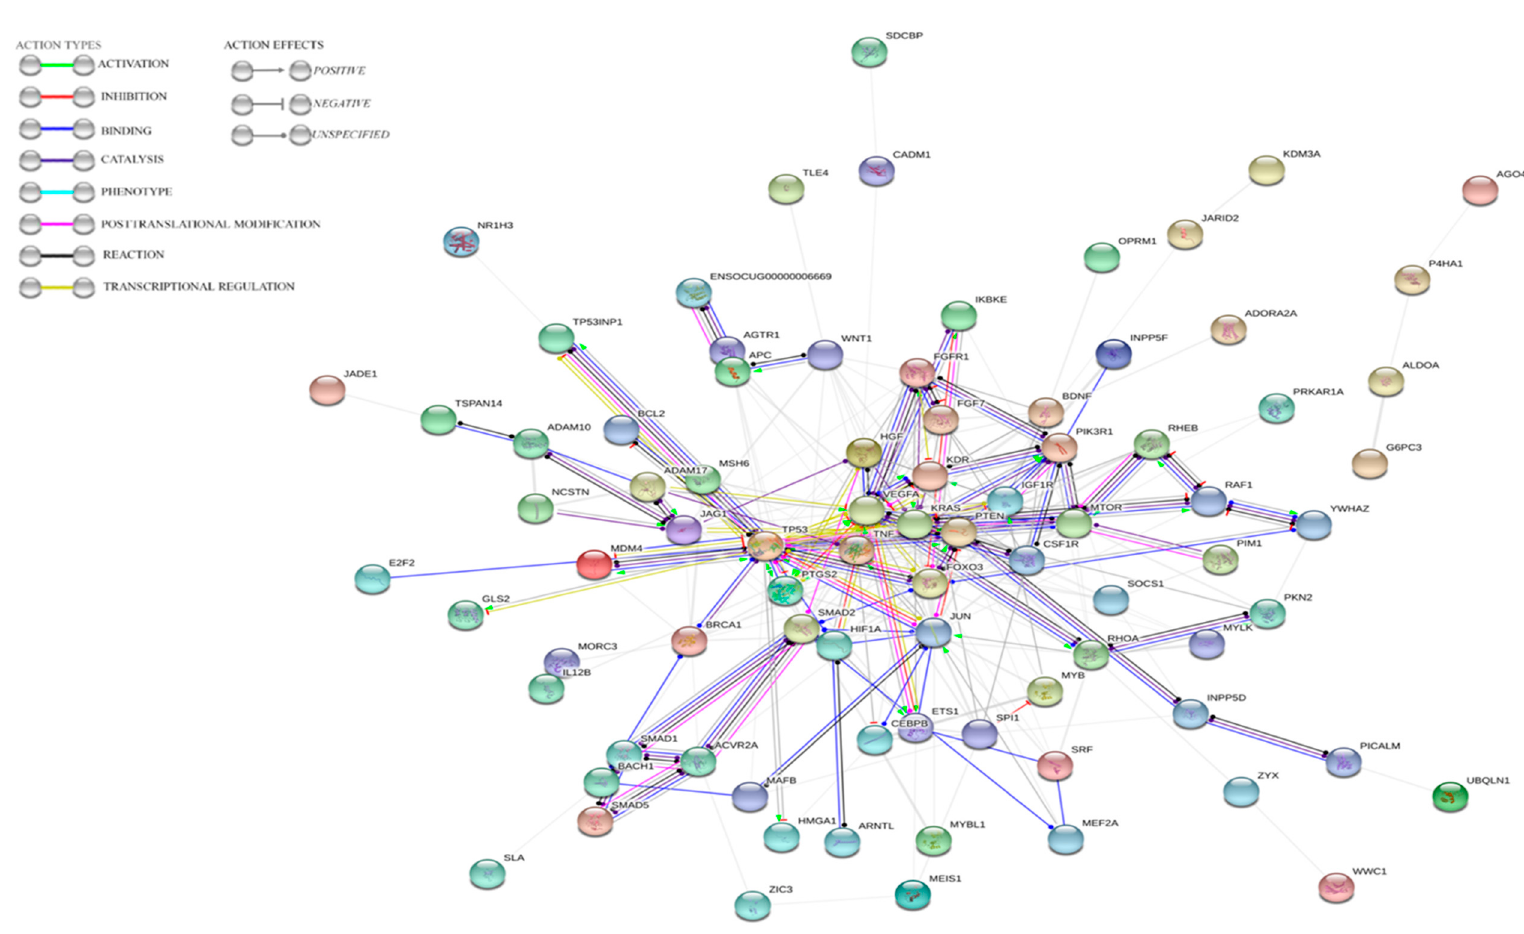
Figure 5. STRING analysis results indicating the dependences between genes potentially regulated by ocu-miR-122-5p, ocu-miR-155-5p, and ocu- miR-16b-5p.